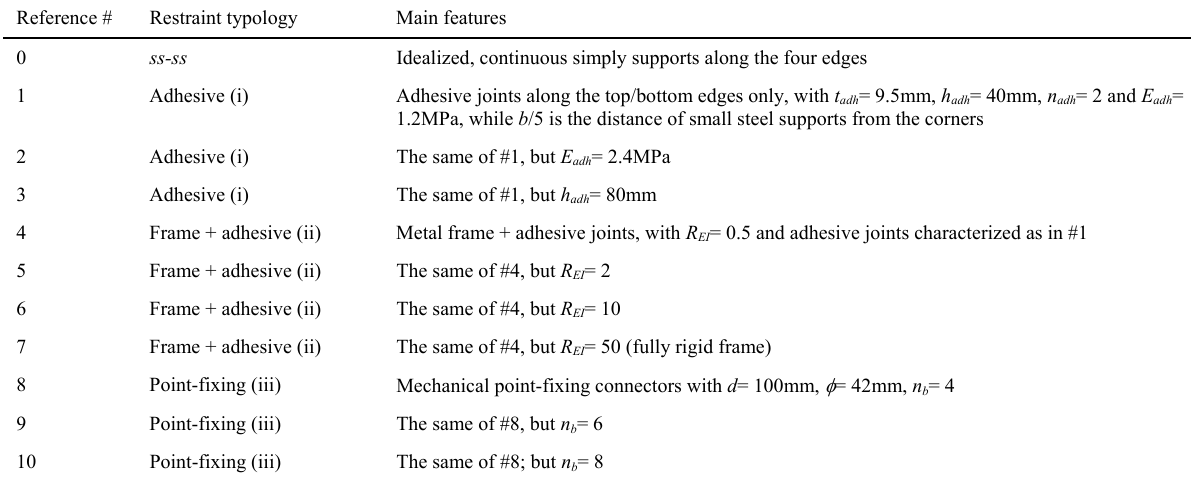
Table 1: Reference restraint properties for the practical examples collected in Figure 10.